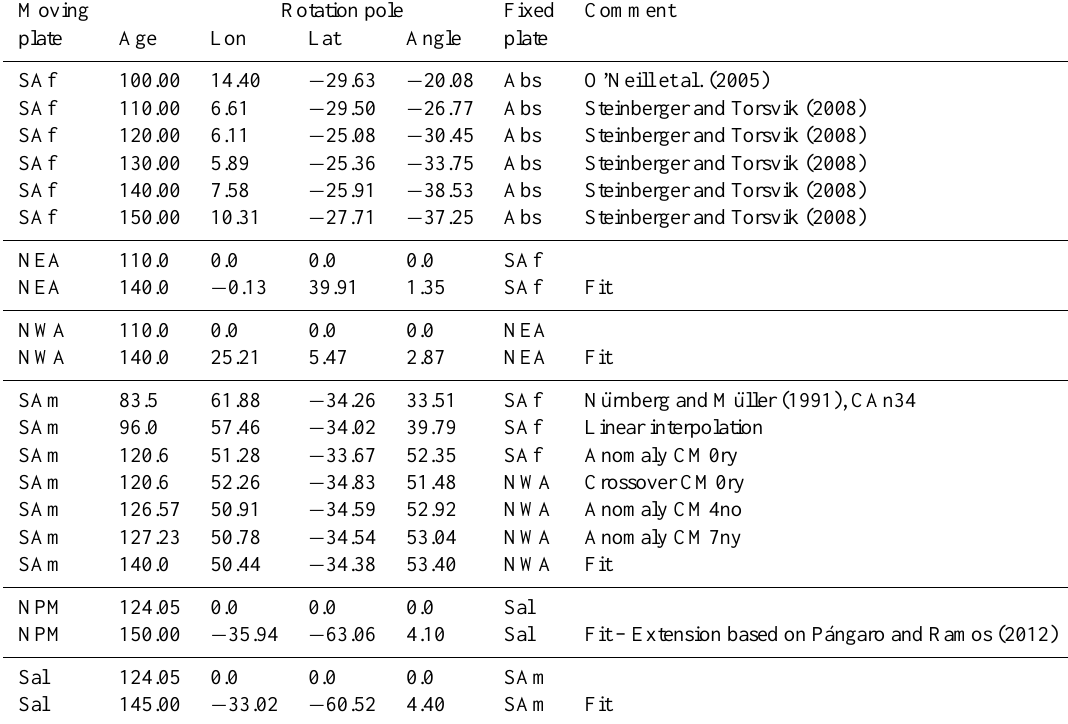
Table 2. Finite rotation parameters for main rigid plates for preferred South Atlantic rift model M1. Abbreviations are Abs – absolute reference frame; SAf – southern Africa; NEA – northeast Africa; NWA – northwest Africa; Sal – Salado Sub-plate; NPM – North Patagonian Massif block; CM – Mesozoic magnetic anomaly chron; y – young; o – old. Magnetic anomaly timescale after Gee and Kent (2007). For microplate rotation parameters please see electronic